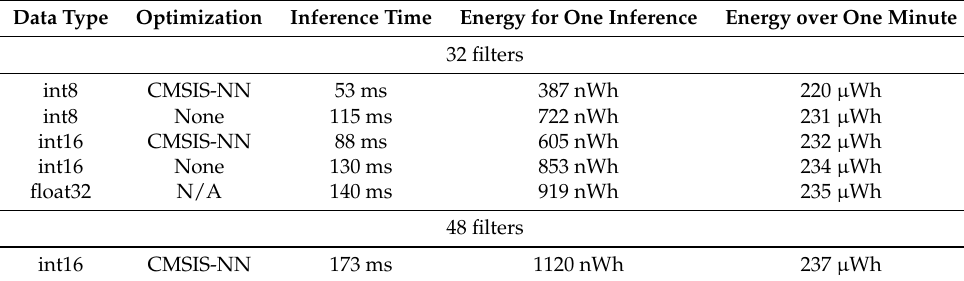
Table 3. Inference time and energy measurements on the smart